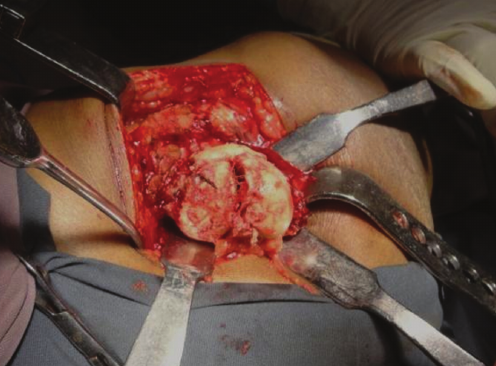
F 3: Intraoperative picture shows fractured and deformed femoral